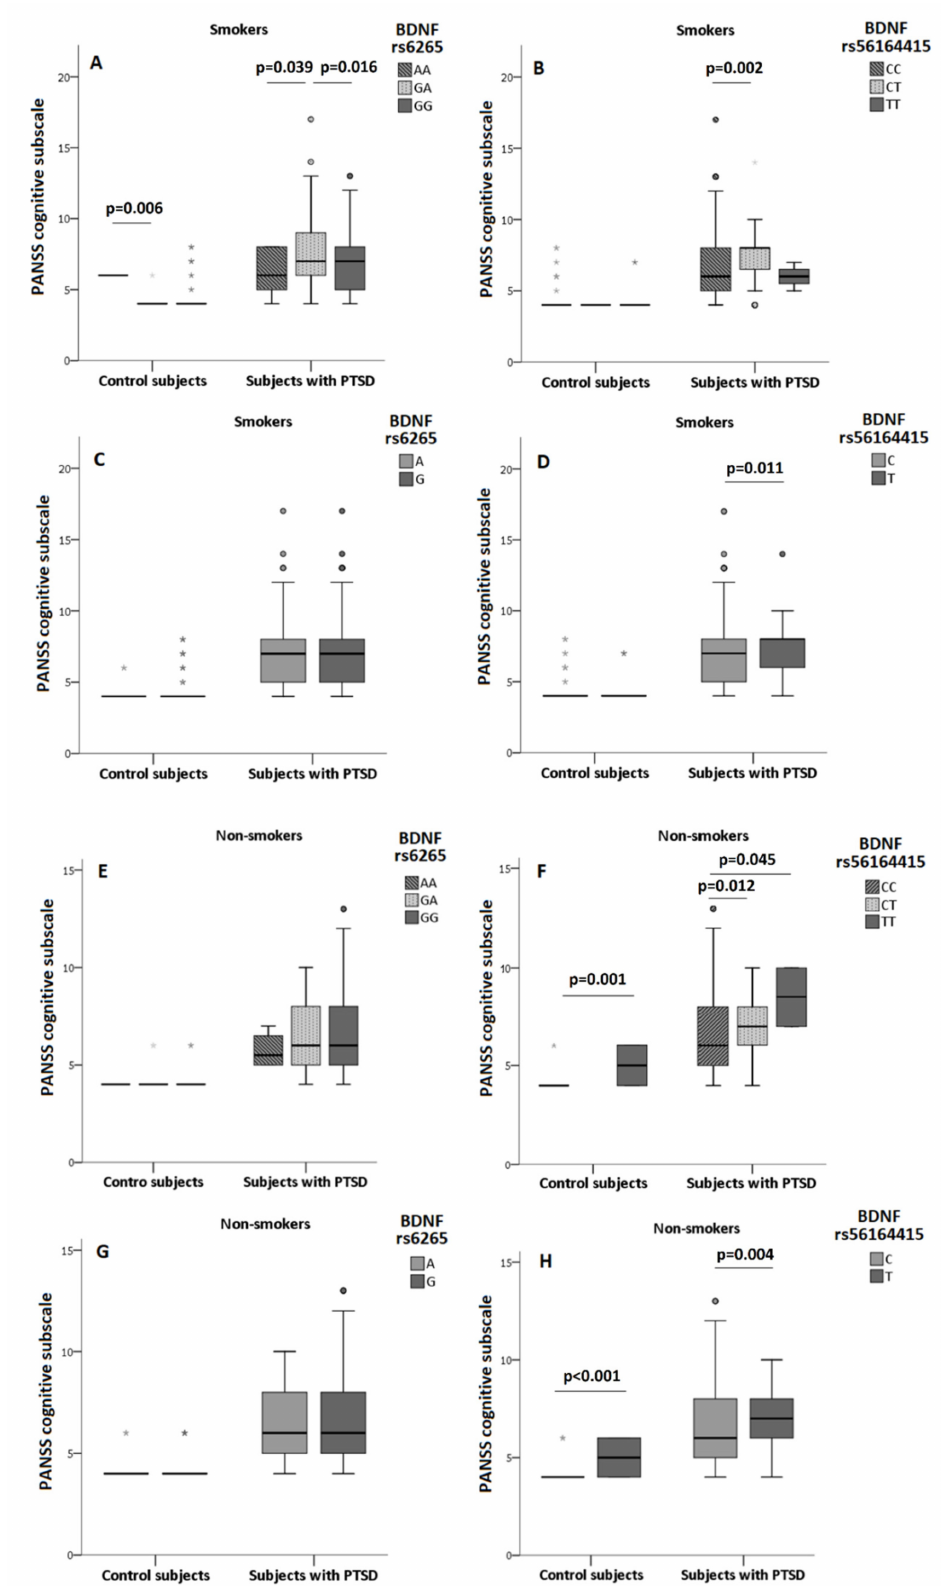
Figure 2. PANSS cognitive subscale scores in control subjects and subjects with PTSD, divided by smoking status, depending on BDNF rs6265 ( A , C , E , G ) and BDNF rs56164415 ( B , D , F , H ) polymor- phisms. Results are shown using the box and whiskers plot, where the central box represents